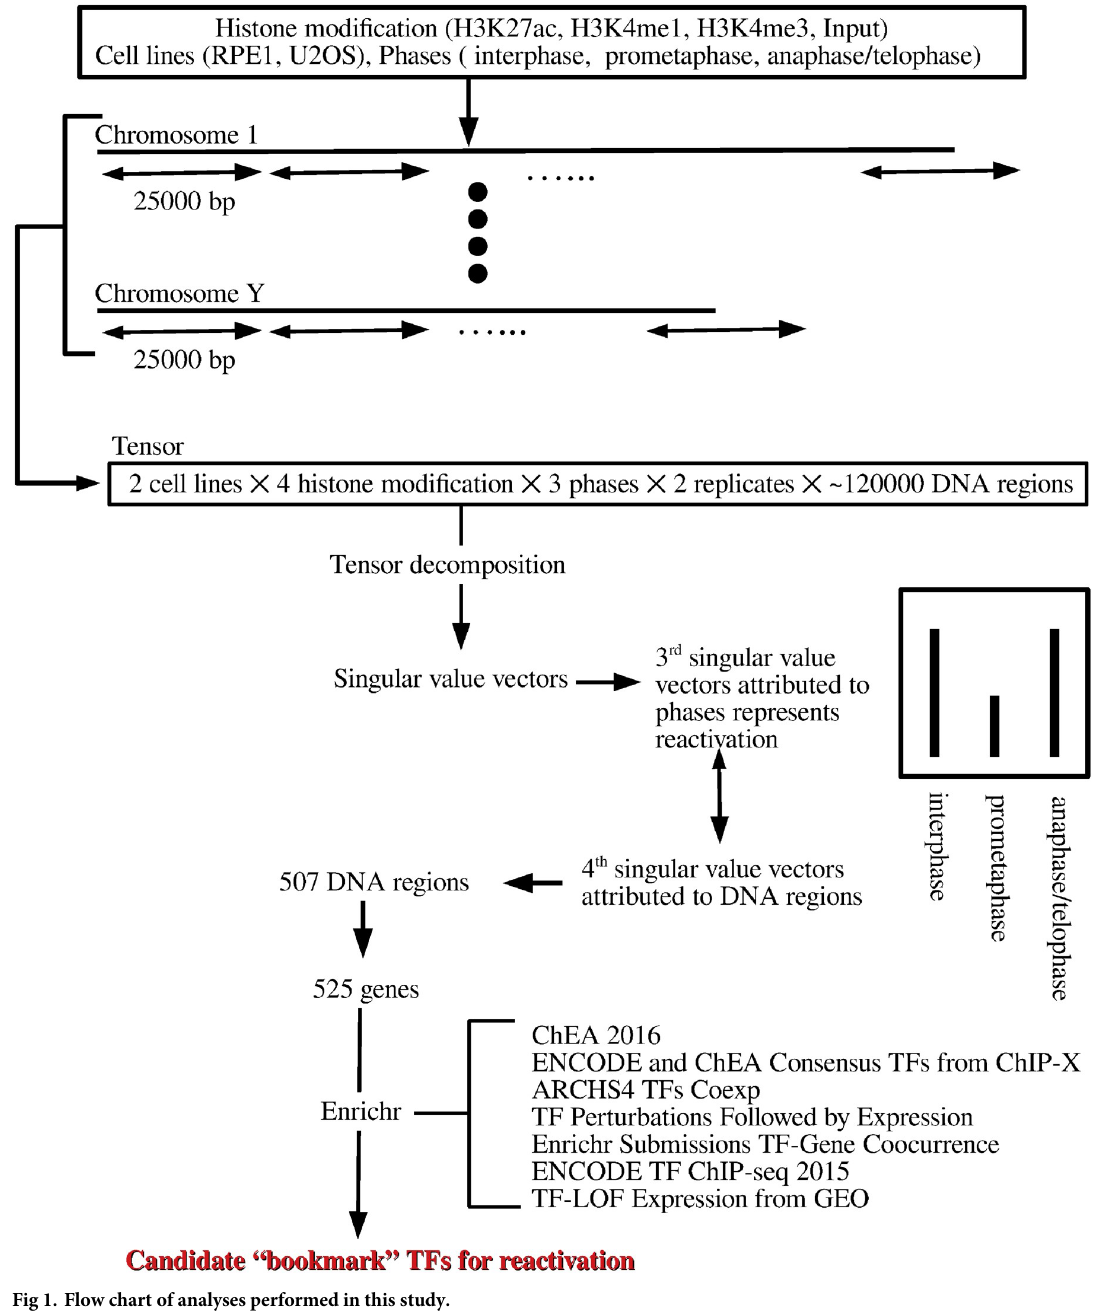
Fig 1. Flow chart of analyses performed in this